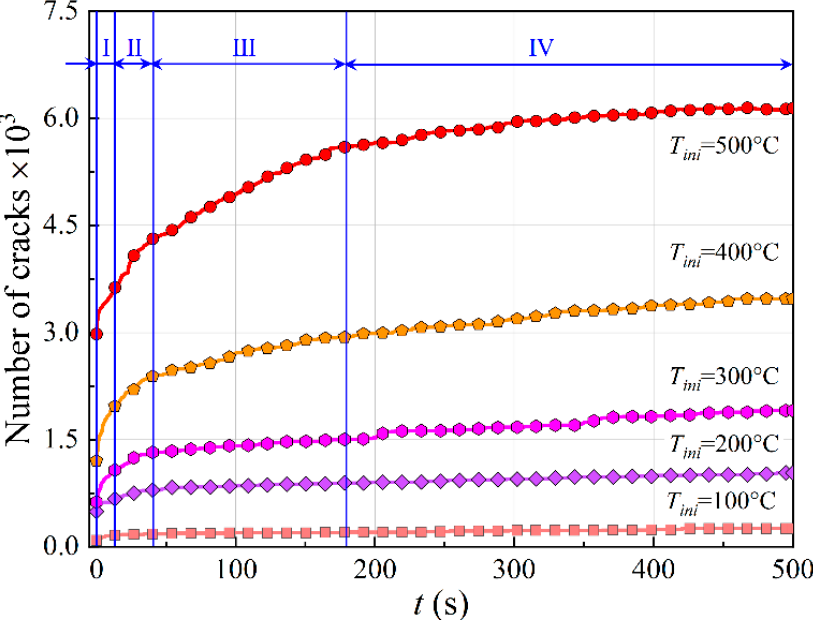
Figure 9. Evolutions of the number of the microcracks in samples with various initial tempera-